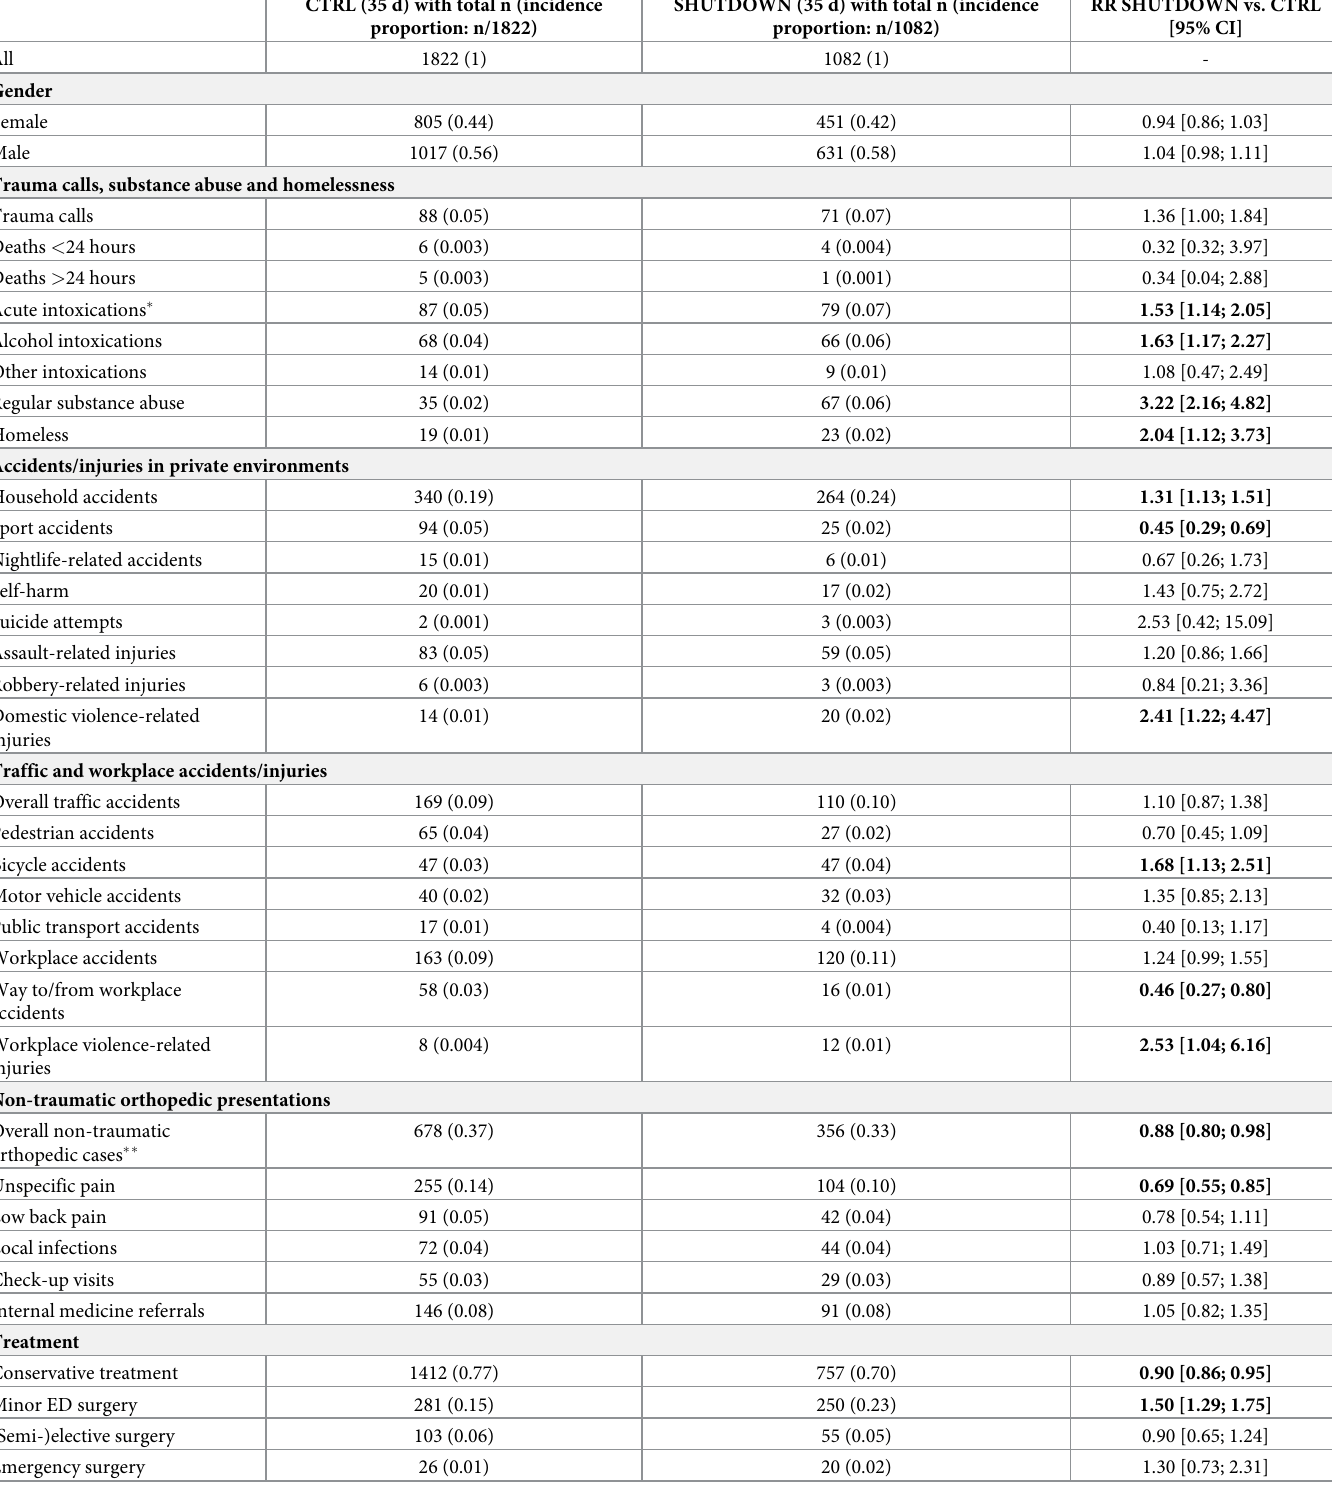
Table 2. Summarized demographics, trauma environments, trauma causes, non-traumatic orthopedic presentations, treatment and discharge metrics before and during the COVID-19 shutdown in Berlin,